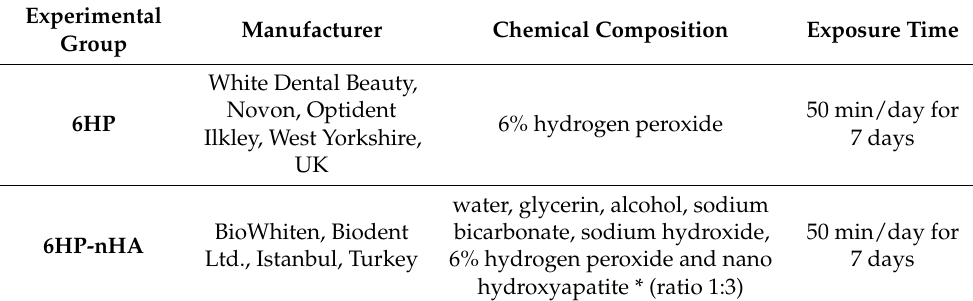
Table 1. Details of the used bleaching